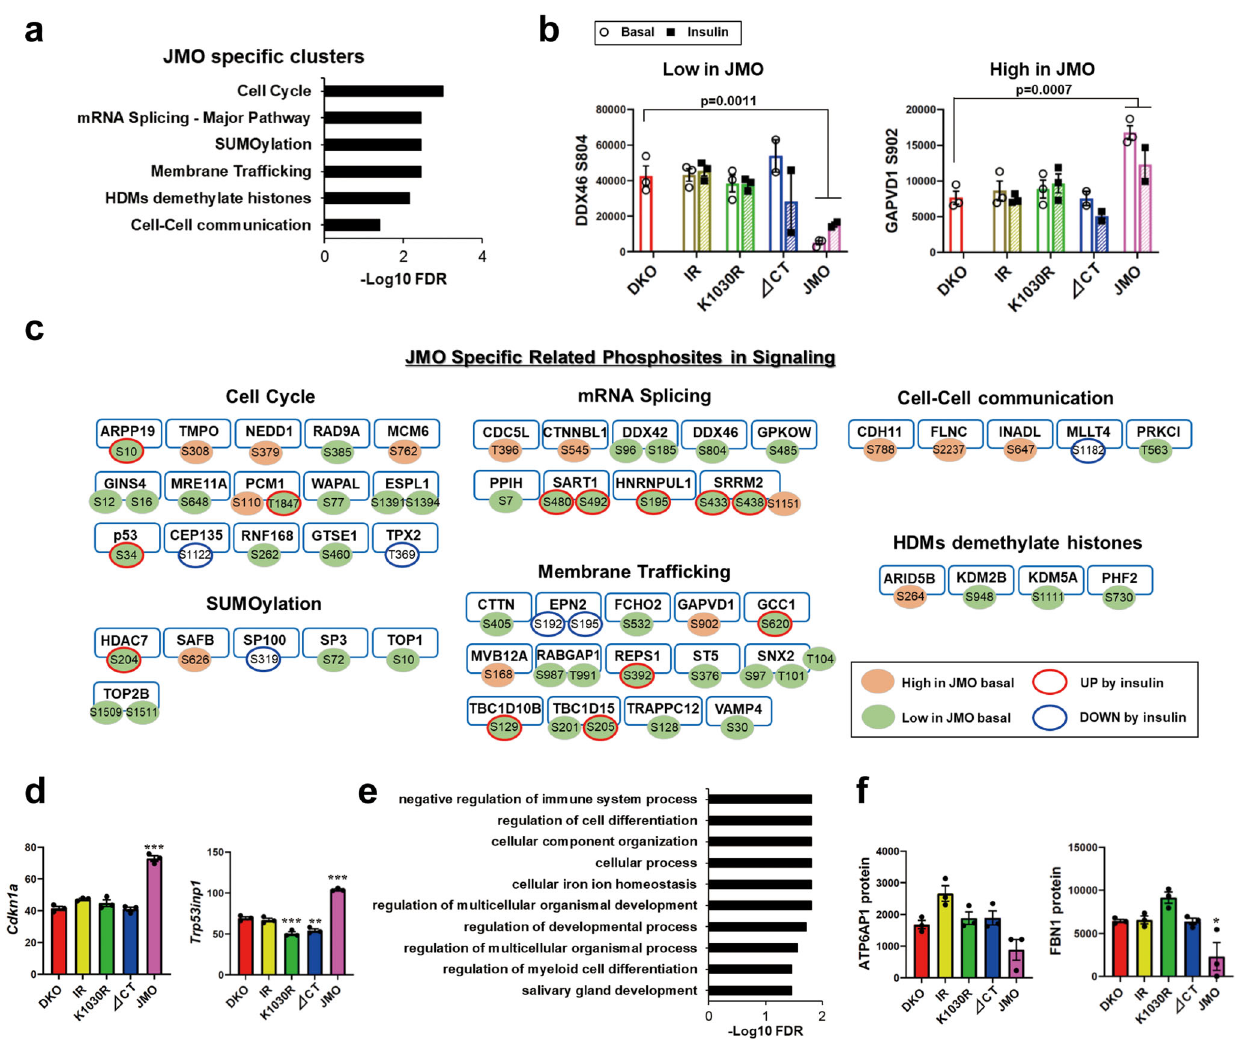
Fig. 7 | JMO dependent signature in signaling and gene and protein expres- sions. a REACTOME pathway enrichment analysis of phosphosites regulated by JMO-IR. The functional enrichment analysis was tested by the STRING database, where FDRs were calculated using the Benjamini – Hochberg procedure. Plots are − log10 transforms of enrichment FDR value. b Quanti fi cation of exemplary phos- phosites in the enriched pathways (in ( a )) in the “ JMO speci fi c ” cluster. Data are means±SEM of phosphosites intensity values (×10 4 ). P -values vs. DKO (combined both basal and insulin for comparisons), one-way ANOVA followed by Dunnett ’ s multiple comparisons test ( n =3 – 6). c Diagram of intracellular signaling regulated byJMO-IRasidenti fi edbyphosphoproteomics.Eachofthephosphositeswascolor-